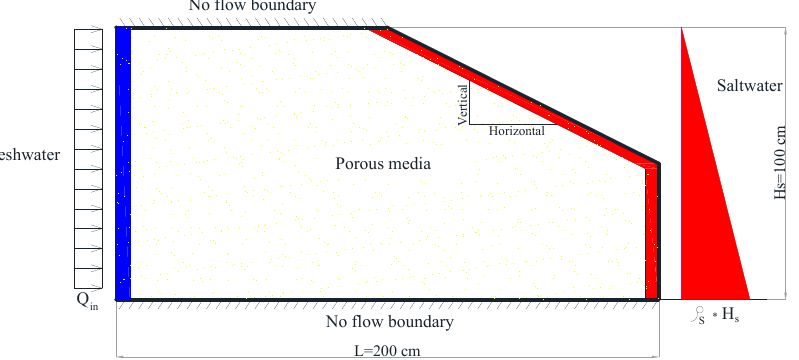
Figure 3. Schematic sketch of different seaside slopes.